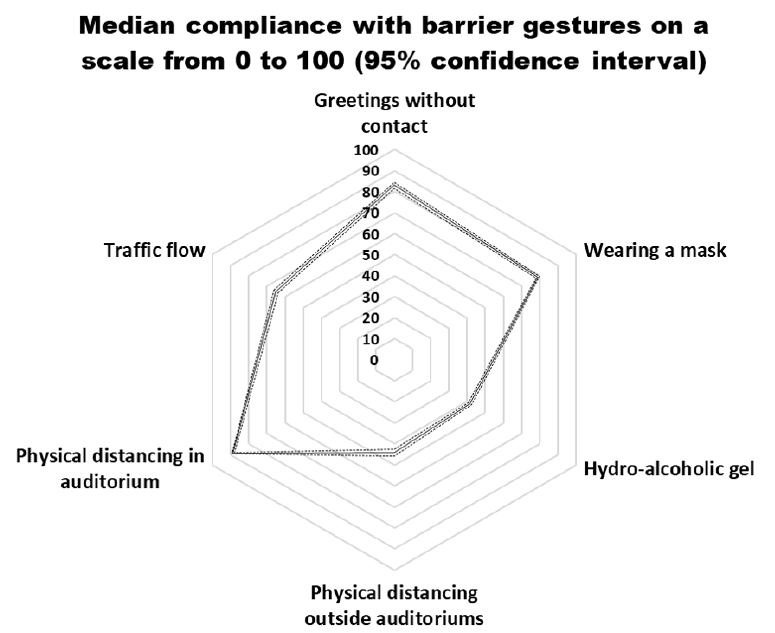
Figure 1. Median compliance with barrier gestures, scale from 0 to 100 (95% confidence interval)